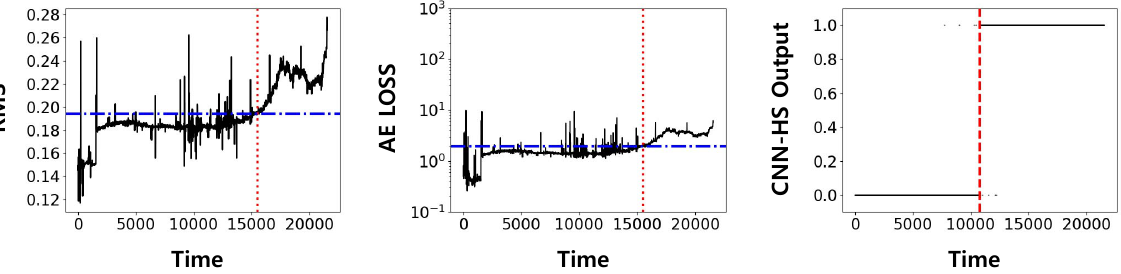
Figure 8. Predicted FPT using root mean square (RMS), auto-encoder (AE), and CNN-HS on IMS dataset (bearing 4). The red horizontal line is the threshold value for RMS and AE, and the red vertical line is the